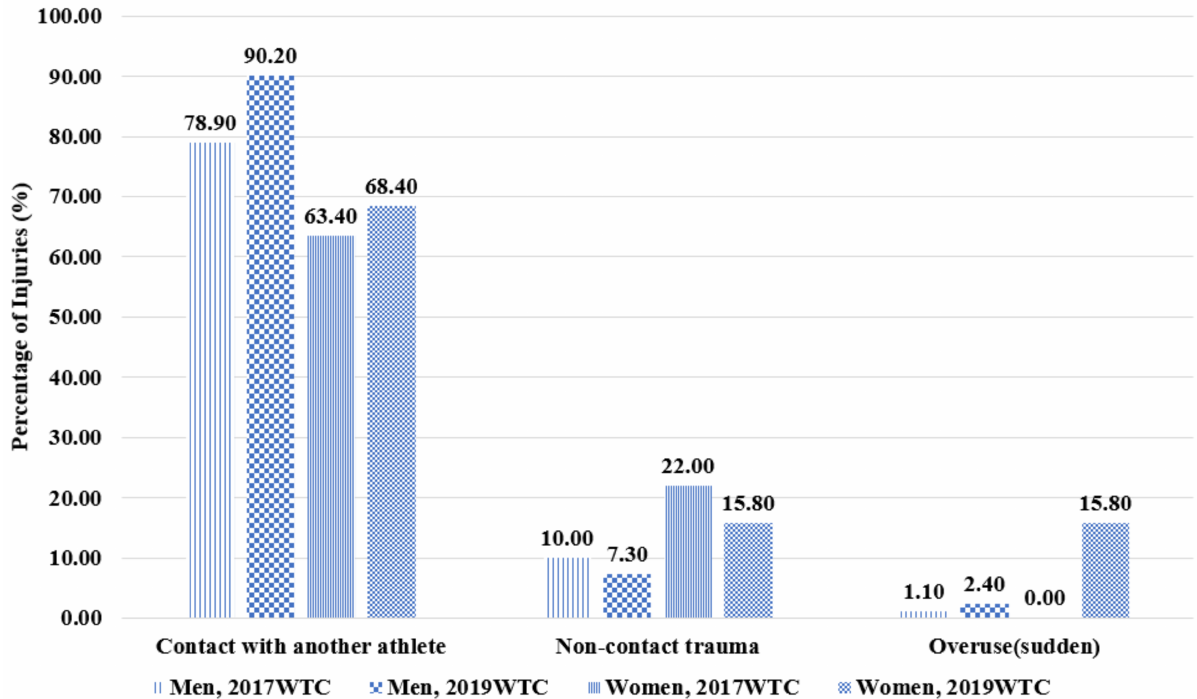
Figure 1. Injury Mechanisms at the 2017 and 2019 World Taekwondo